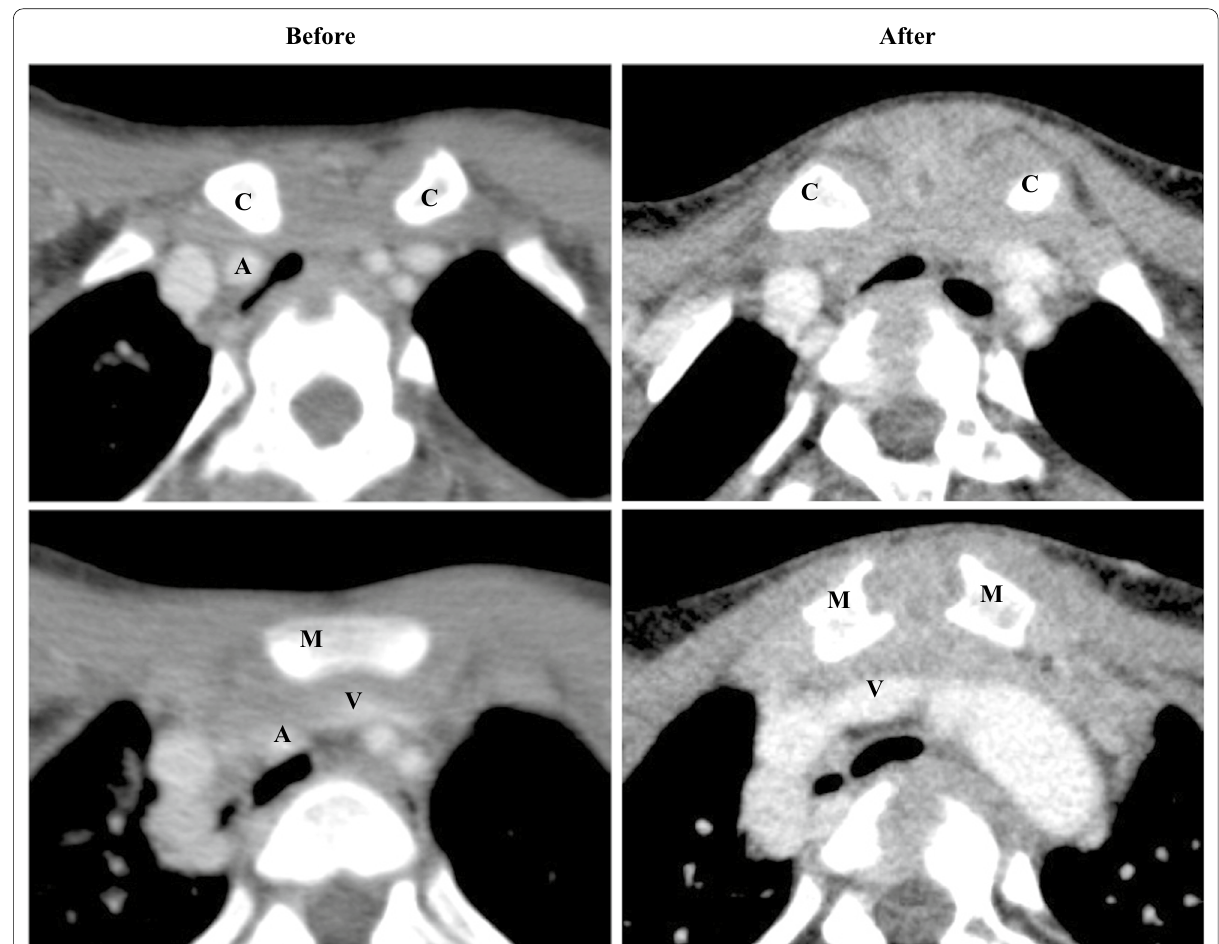
Fig. 2 CT imaging before and after transection of the brachiocephalic artery and thoracoplasty in Patient 1. A brachiocephalic artery; C sternal end of the clavicle; M manubrium sterni; V brachiocephalic